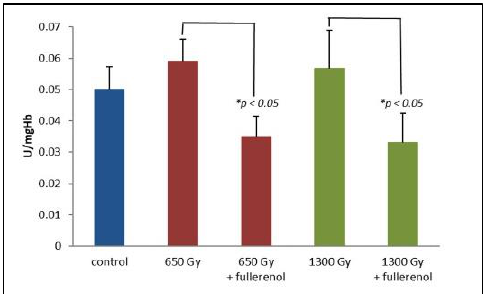
Figure 3. The effect of fullerenol on glutathione transferase (GST) activity. Fullerenol at a concen- tration of 150 µg/mL was added to the erythrocyte suspension 1 h before irradiation with doses of 650 and 1300 Gy. Measurements were taken 2 after irradiation and haemolysis. The bars represent mean values ± SD for 3 independent measurements. * Statistically significant values at p < 0.05.